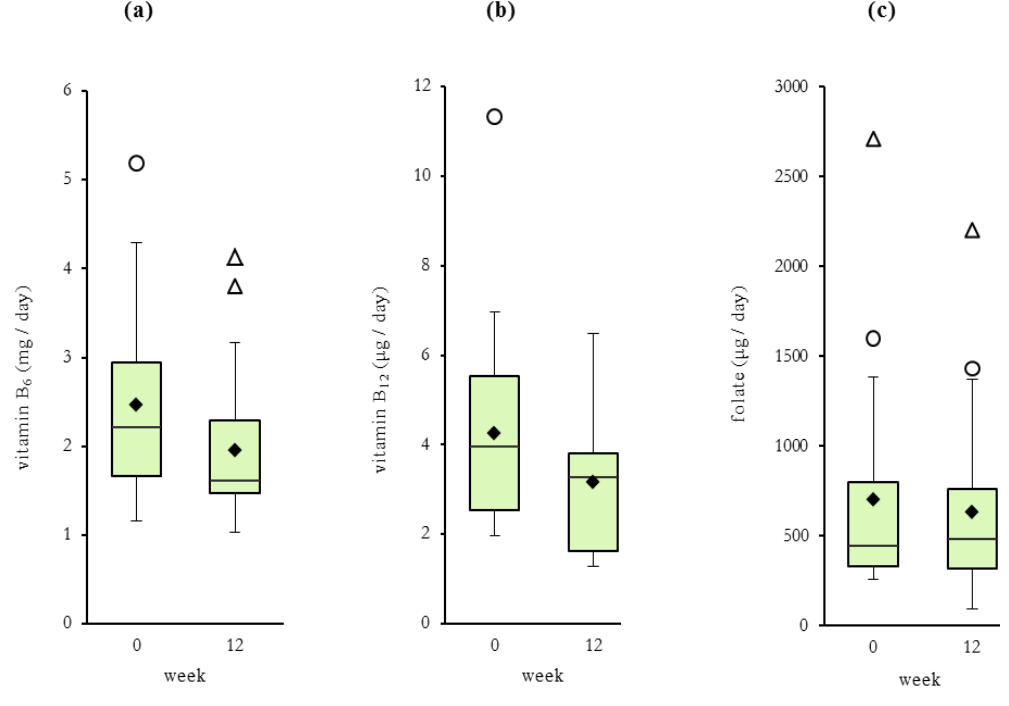
Table 3. Reported contributors of dietary vitamin B